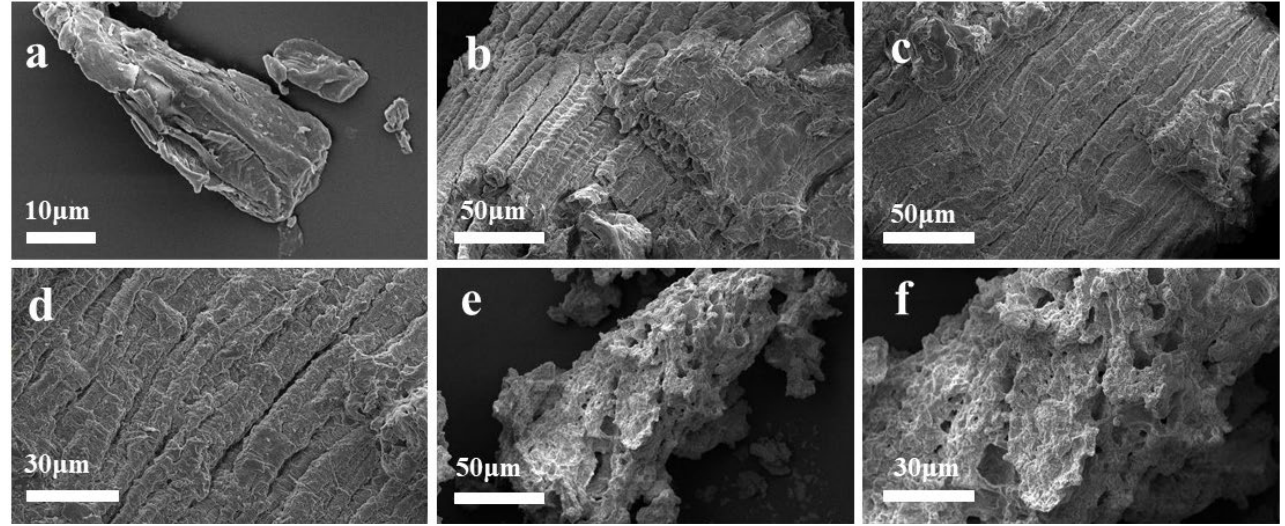
Figure 5. SEM images of the feedstock corncob ( a ), R1 ( b , c , d ), and R2 ( e , f